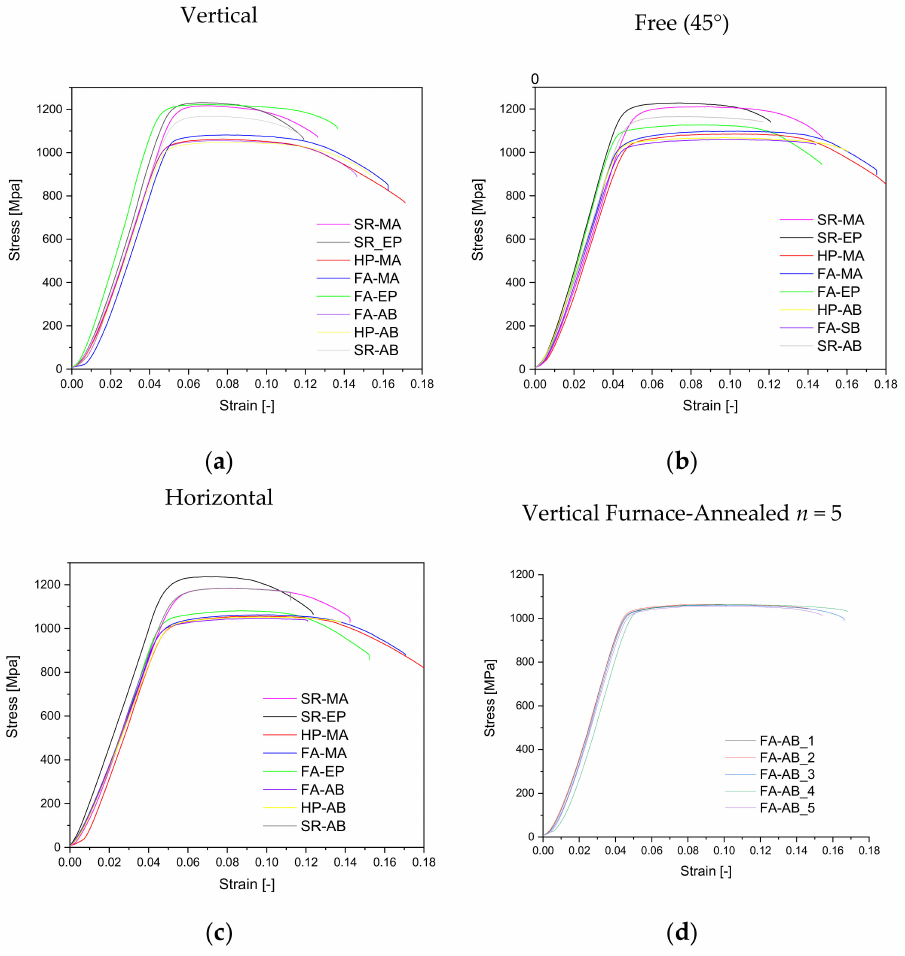
Figure 5. Stress–strain curves for ( a ) vertical, ( b ) free, and ( c ) horizontal orientations and ( d ) 5 tests of vertical, furnace-annealed, and as-built